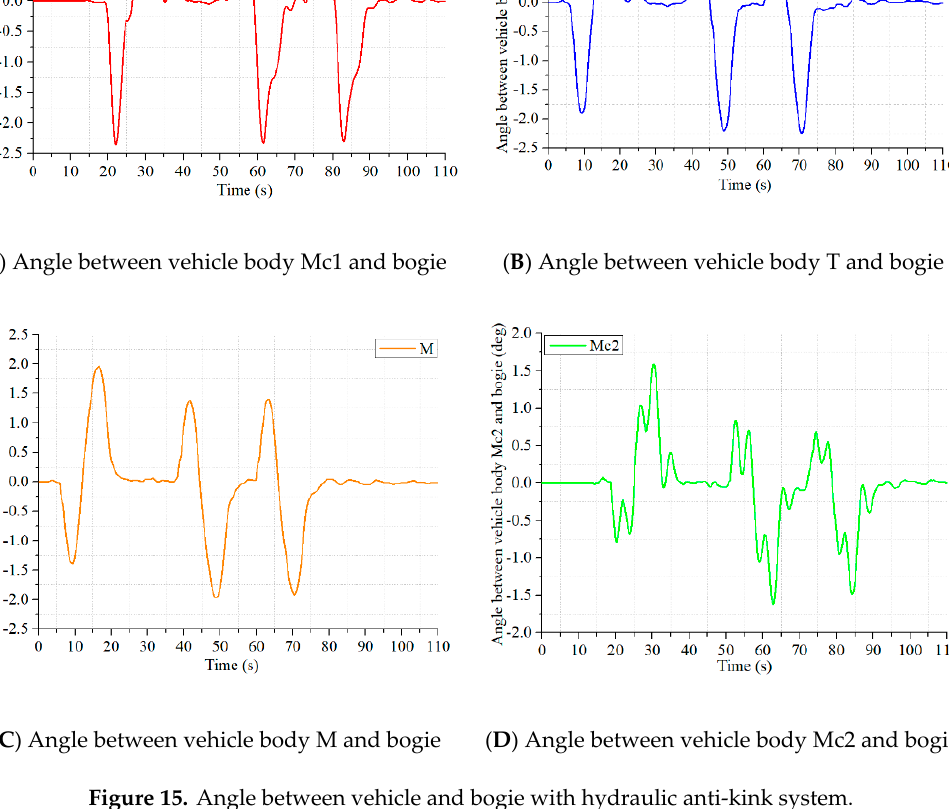
Figure 15. Angle between vehicle and bogie with hydraulic anti-kink system.